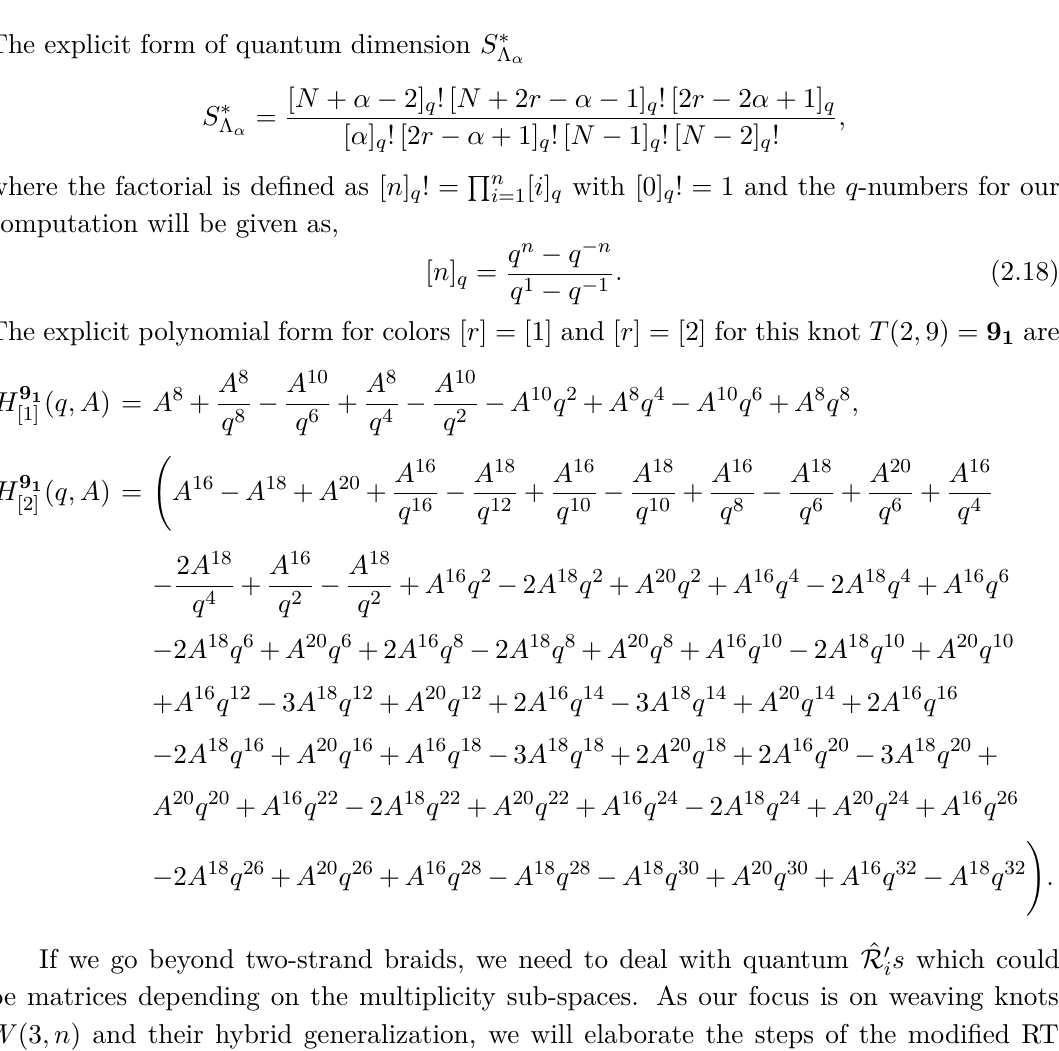
Figure 1 . Torus knot T